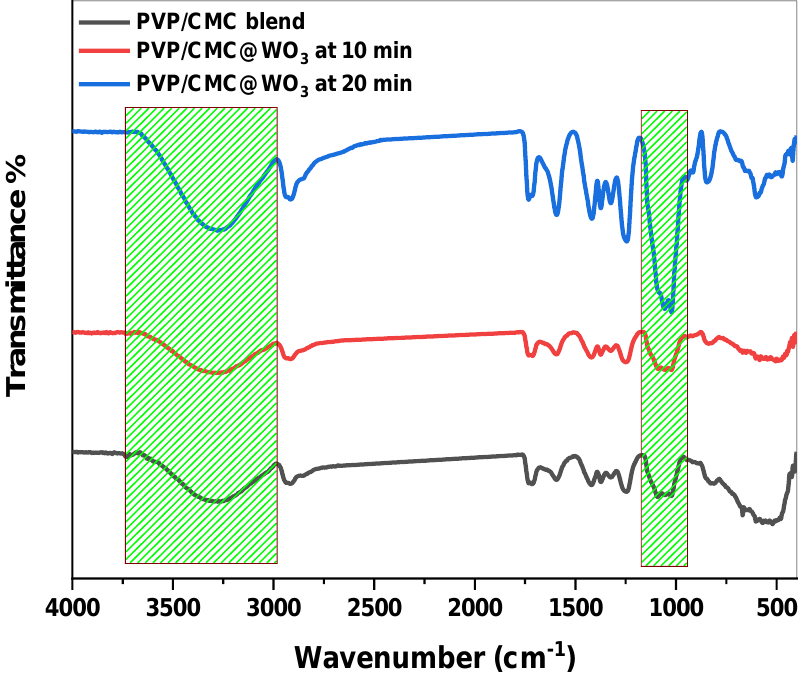
Figure 2. FT-IR band of polymer blend PVP/CMC and blend filled with WO 3 at 10 min and 20 min laser-ablation time.